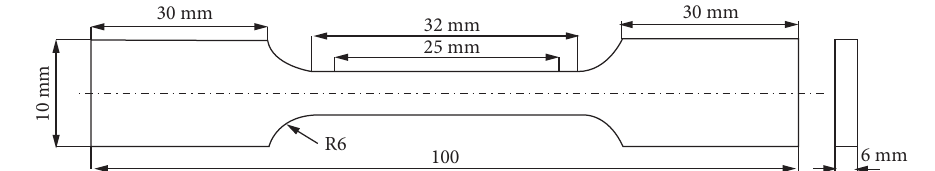
Figure 5: Dimensions of the tensile specimen (ASTM E8M-04).